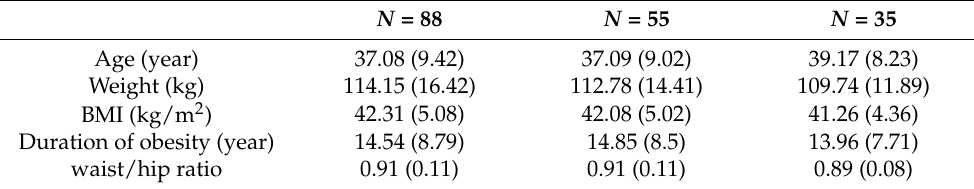
Table 1. Anthropometric characteristics of included ( N = 88), analyzed ( N = 55) and complete follow-up ( N = 35) patients with duodenal biopsies.